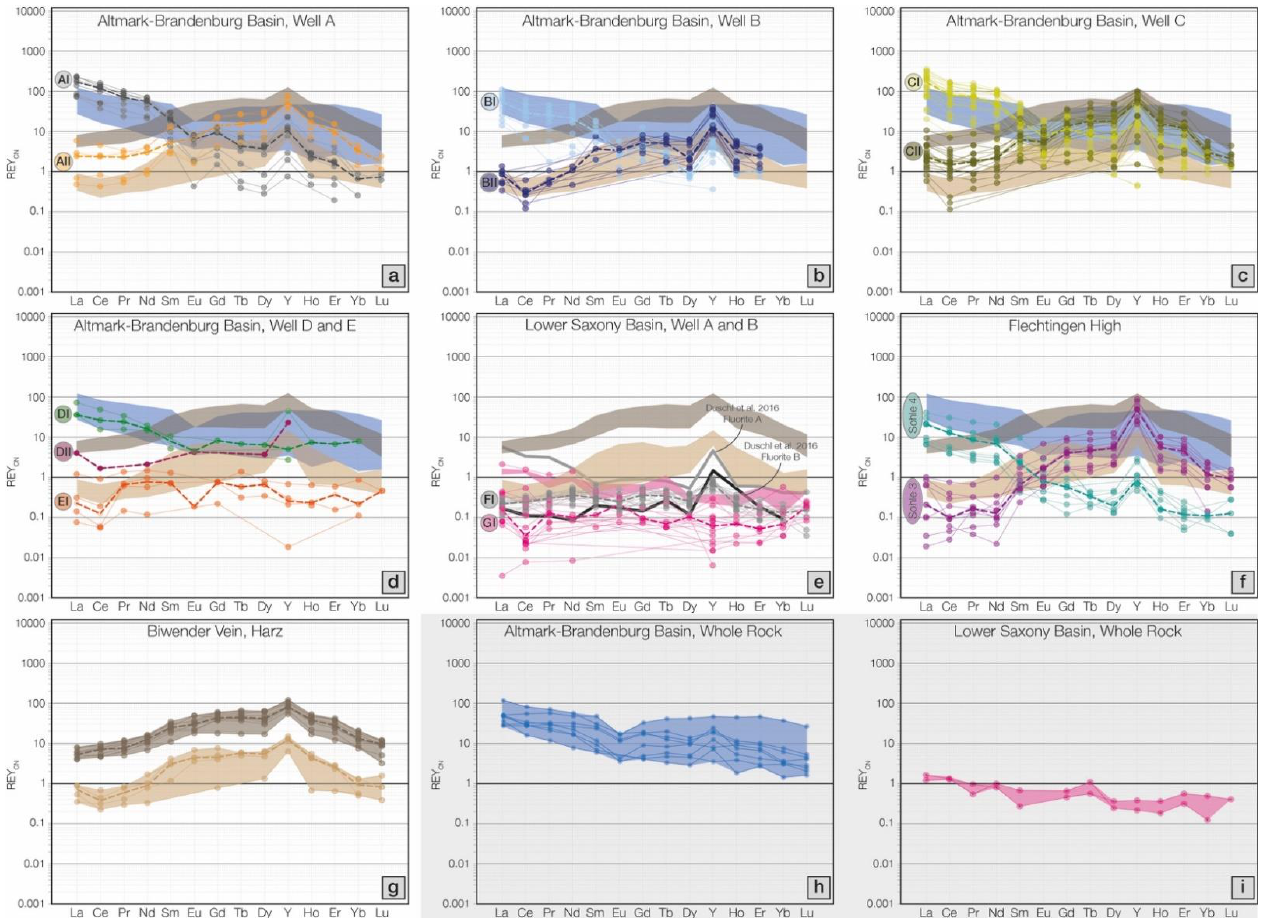
Figure 5. C1 chondrite-normalized, [after 76] REY CN plots for fluorite ( a – g ) and whole rock samples ( h , i ) from ABB ( a – d ), LSB ( e ), Flechtingen High, FCB ( f ), and Biwender Vein (Harz) ( g ). Median values are represented by the dashed lines. Compositional ranges for the Biwender Vein and the ABB and LSB whole rock data are plotted as references in the background in plots where applicable. Colour coding corresponds to Figure 4. The corresponding REY concentrations are listed in Table 3.